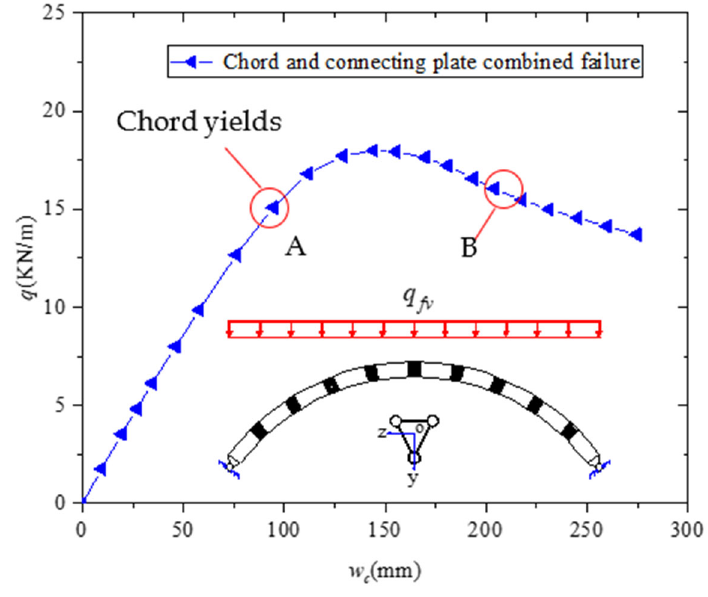
Figure 21. Vault load–displacement curve of combined chord and connecting plate failure.